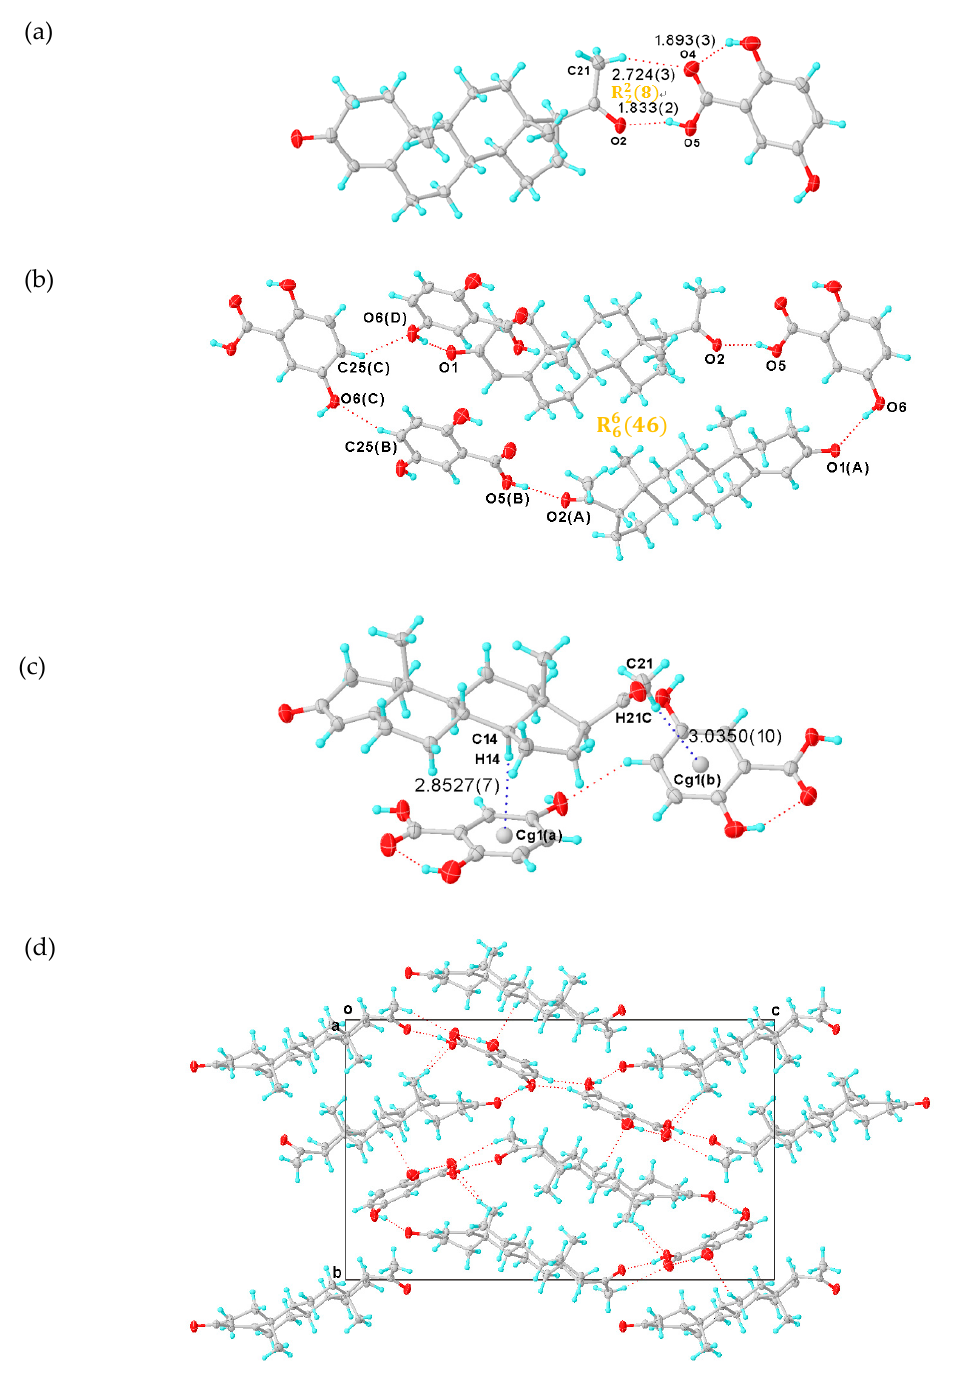
Figure 3. ( a ) Asymmetric unit of PROG-DHB. ( b ) Hydrogen-bonded pattern of PROG-DHB. ( c ) C-H ··· π interactions (blue dashed line) in PROG-DHB. ( d ) Packing diagram of PROG-DHB along the axis. The ellipsoids are drawn with 30% probability and all hydrogen bonds are represented with dotted lines. Symmetry codes: A: 1 / 2 + X, 3 / 2 − Y, 1 − Z; B: 1 / 2 + X, 3 / 2 − Y, 1 − Z; C: + X, + Y, 1 + Z; D: − 1 / 2 + X, 3 / 2 − Y, 1 − Z.